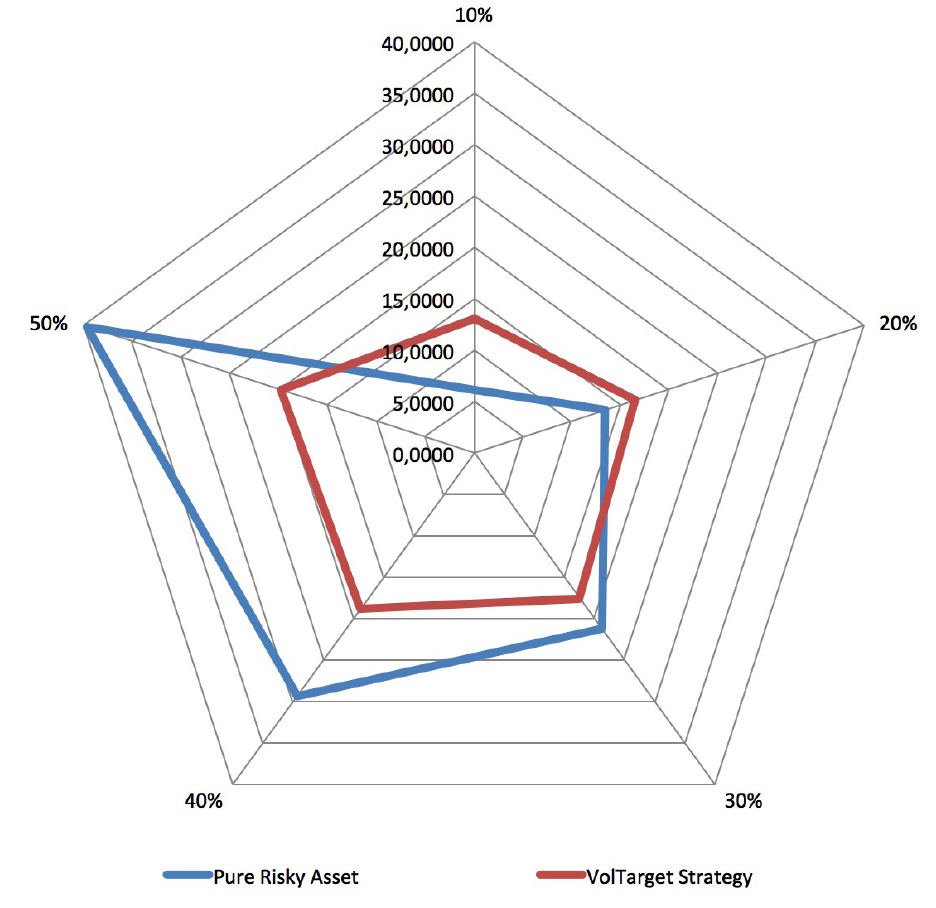
Figure 2. American lookback option prices with a maturity of one year and a protection level of